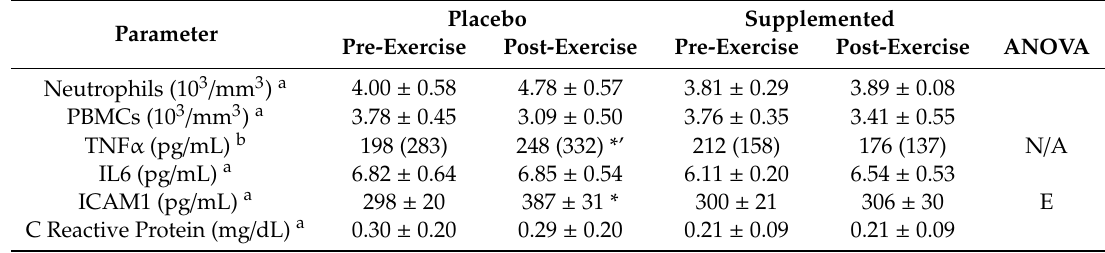
Table 4. E ff ect of exercise and nitrate supplementation on white blood cell counts and inflammation plasma markers.